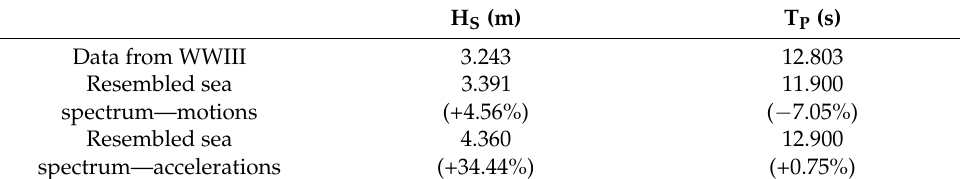
Table 3. Parameters of rebuilt spectrum for a combined sea spectrum—7 January 2020.